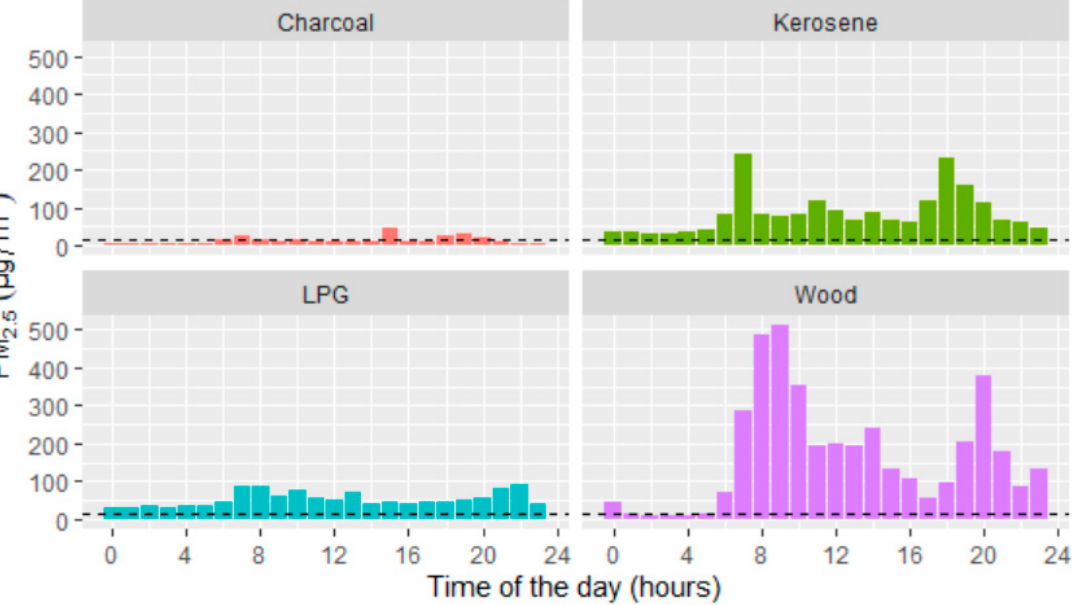
Figure 3. Graph showing hourly variation of PM 2.5 grouped by fuel type. Dotted line plotted at 15 µg/m 3 , which is the mean 24 h WHO limit.